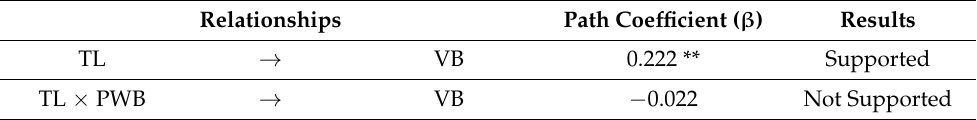
Table 2. Path results. Relationships Path Coefficient ( β ) Results TL → VB 0.222 ** Supported TL × PWB → VB − 0.022 Not